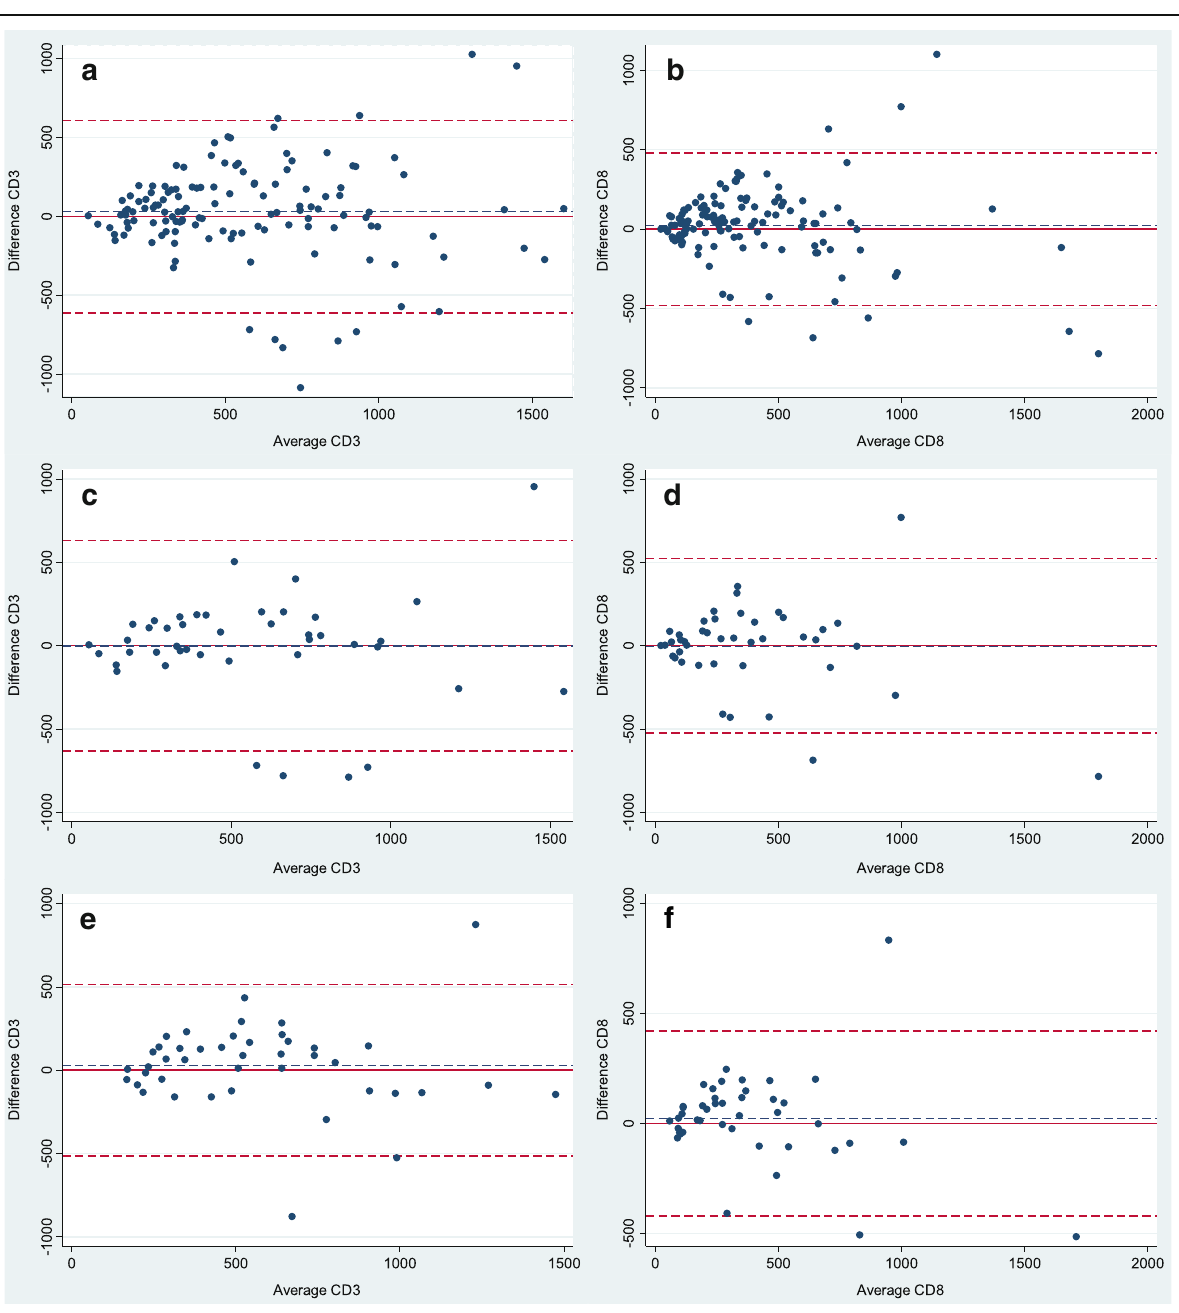
Fig. 8 Bland Altman plots showing the differences in densities of CD3+ and CD8+ tumor infiltrating lymphocytes for the central and invasive area measured by image analysis. The horizontal red line corresponds to zero difference, the blue dashed line shows mean and the dashed red lines show ±1.96 standard deviation. a and b ) Differences for densities of CD3+ and CD8+ tumor infiltrating lymphocytes (TILs) for all sections ( n = 129). c and d ) Differences for densities of CD3+ and CD8+ TILs for “ the deepest invasive sections ” ( n = 43). e and f ) Differences for densities of CD3+ and CD8+ TILs per tumor, where density is calculated as an average of the densities obtained from each of the three sections from each tumor ( n =